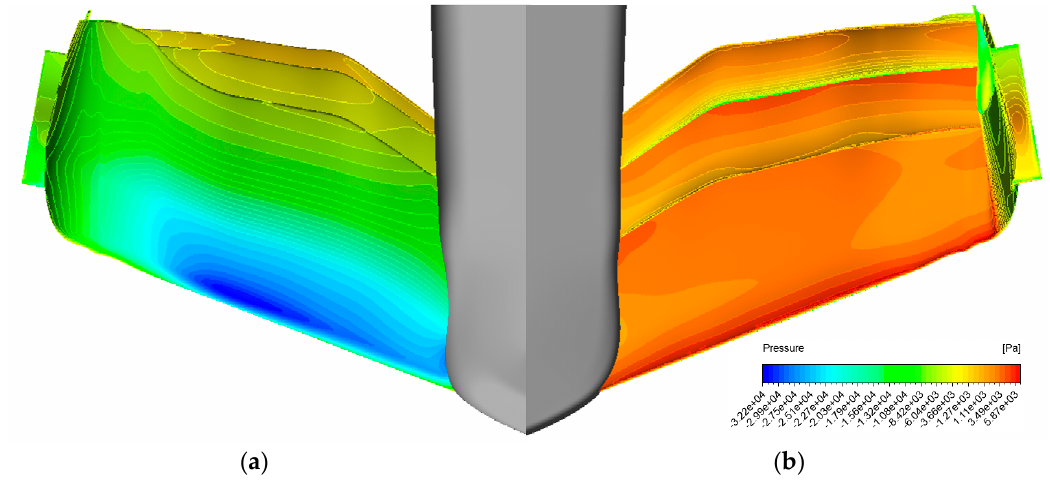
Figure 12. Pressure field in lower ( a ) and upper ( b ) surfaces of the Formula One 2022 front wing.